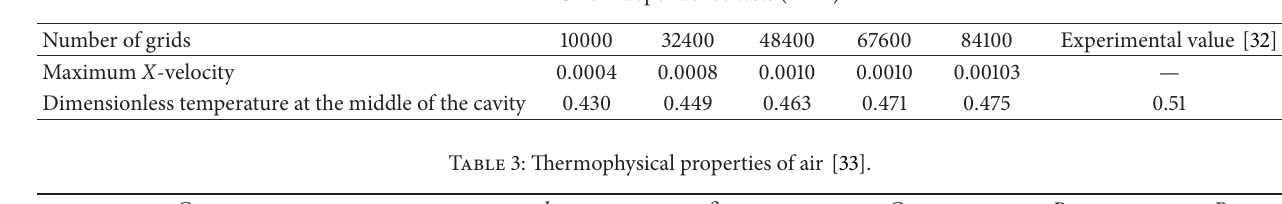
Table 2: Grid independence tests (LBM).